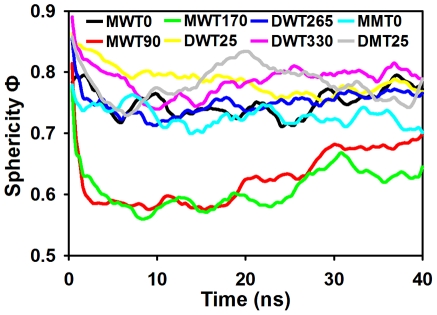
Time evolution of globulomer sphericity for DWT25 (black), DWT265 (red), DWT330 (green), MWT0 (yellow), MWT90 (blue), MWT170 (pink), D25M (cyan), and M0M (gray).